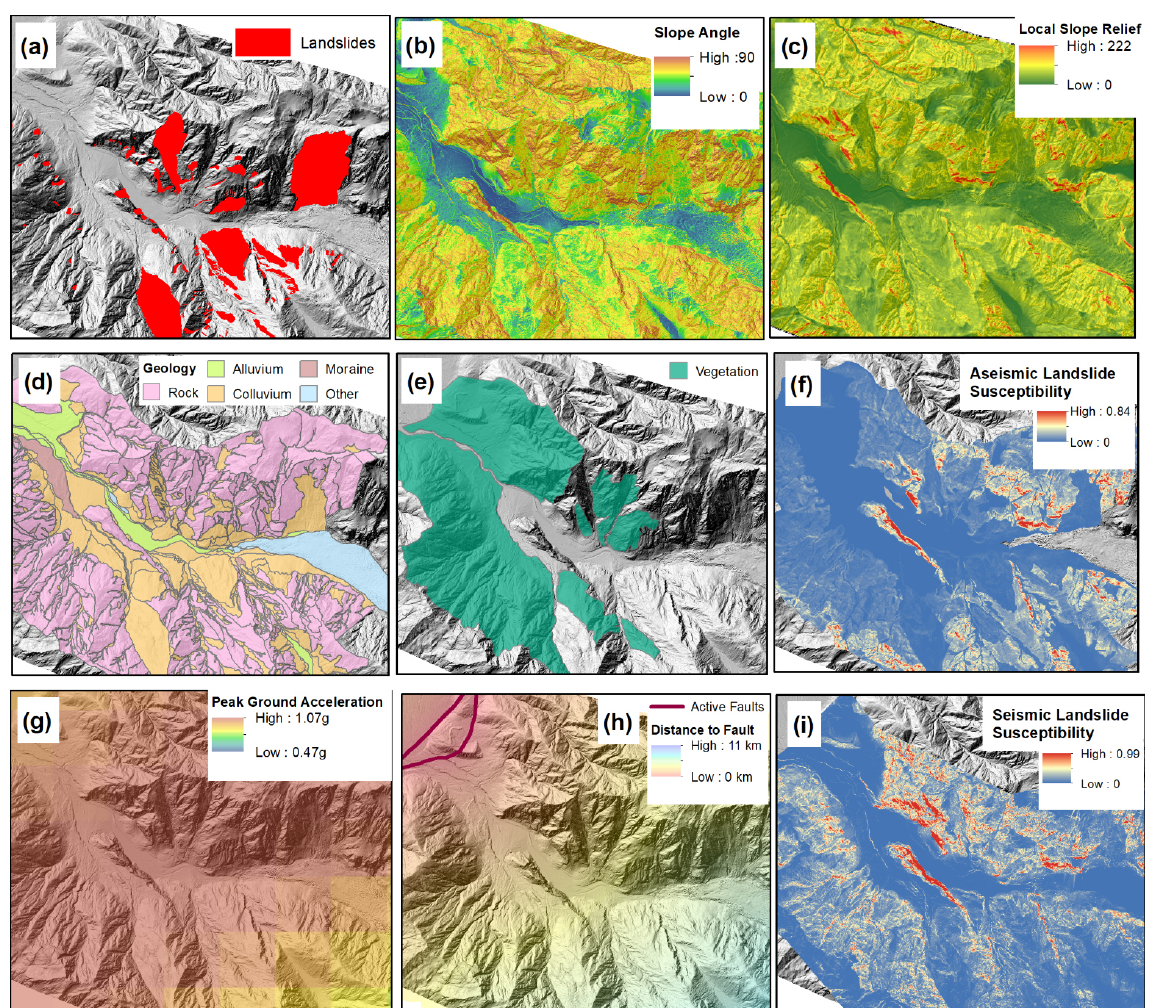
Figure 4. Generation of both aseismic and seismic logistic regression models for the Fox Glacier valley. The aseismic logistic regression model is determined from the correlation between (a) the landslide inventory and the static variables of (b) slope angle, (c) local slope relief (LSR, defined as the maximum height difference within a fixed 80m radius of the grid cell), (d) geology, and (e) vegetation (as classified from imagery and the New Zealand Land Cover Database). The logistic regression model calculates (f) aseismic landslide susceptibility. The seismic logistic regression model is determined from the correlation between (g) peak ground acceleration (PGA) and the static variables of (b) slope angle, (c) local slope relief (LSR), (d) geology, and (h) distance to active faults (Massey et al., 2018). The logistic regression model calculates (i) seismic landslide